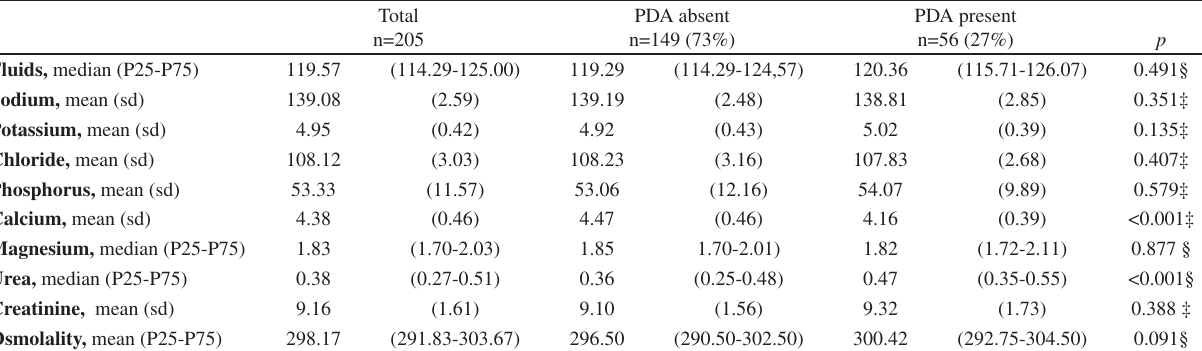
Table 10 - Association between mean values of fluids, electrolytes, urea, creatinine and osmolality during the first week of life and patent ductus